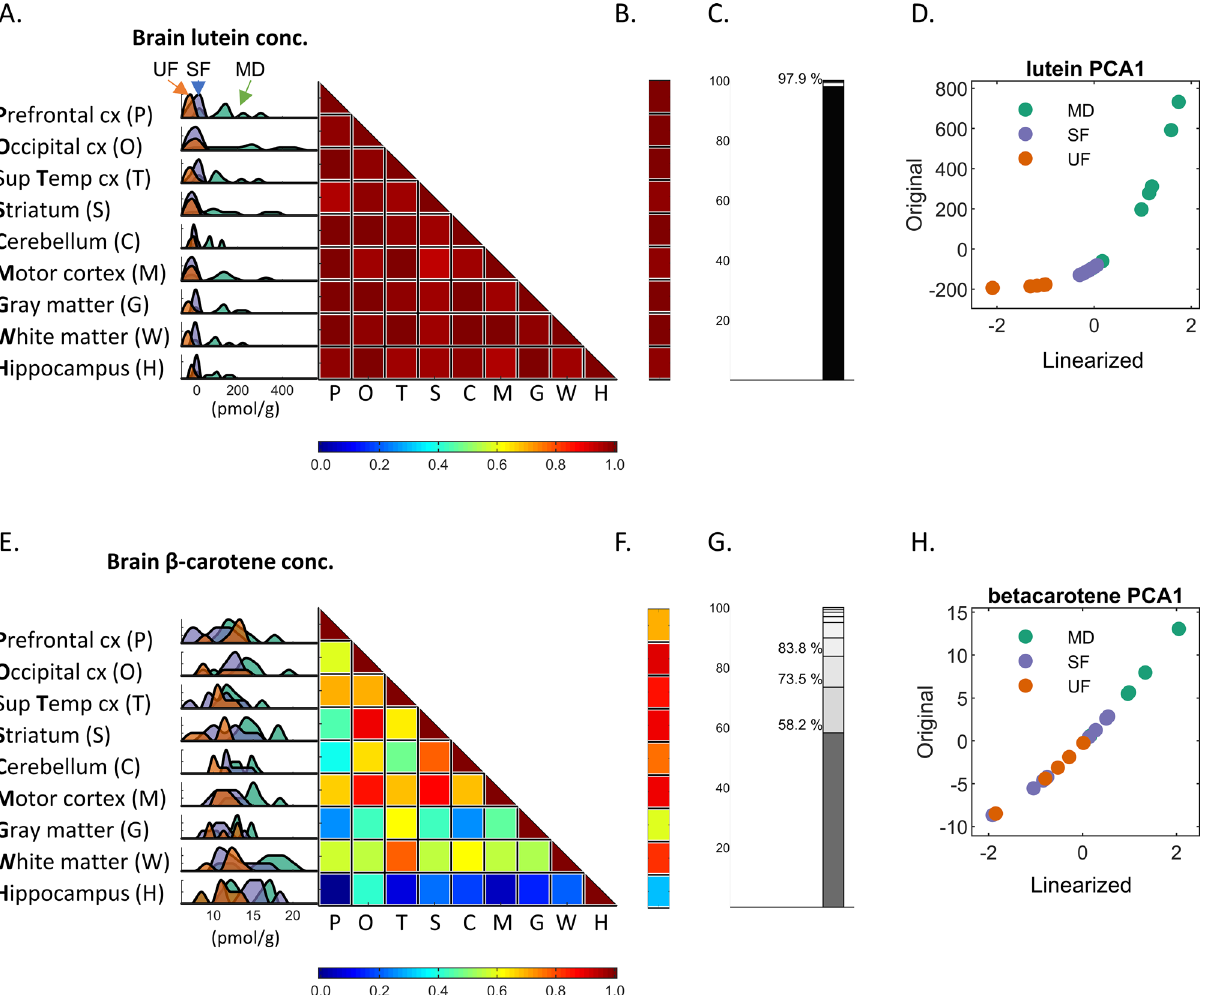
Figure 3. Carotenoid concentrations and composite index. ( A ) Correlation of lutein concentrations across brain areas with color-coded numerical scale and a companion insert displaying histograms with the concentration of lutein in each brain area, color-coded by group: MD, mixed-diet (green); UF, unsupplemented formula (blue); SF, supplemented formula (orange). ( B ) Correlation of the first PCA component with the concentration of lutein for each brain area using the same color-coded scale used in ( A ). ( C ) Explained variance for each component after orthogonalization of lutein’s concentration across brain areas using PCA. ( D ) PCA’s first component row-scores (y-axis) and transformed scores using a logarithmic (BoxCox) transformation. Similar data for β-carotene is shown in ( E – H